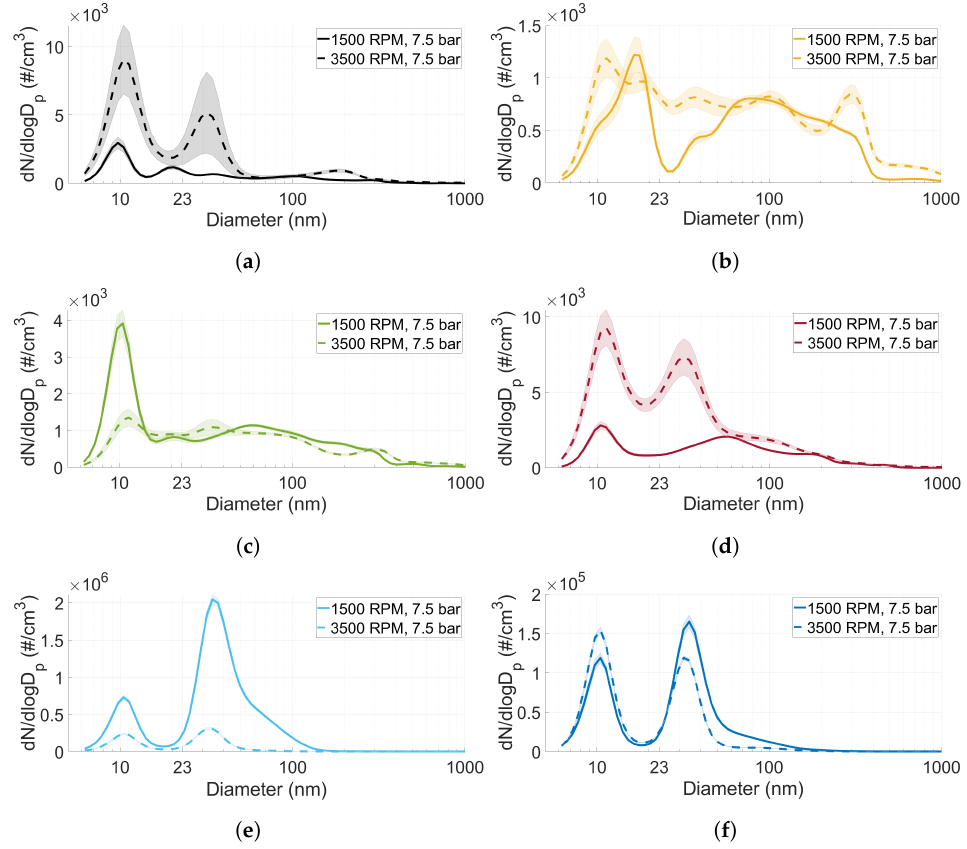
Figure 6. The total particle size distribution for ( a ) gasoline, ( b ) MTBE, ( c ) ethanol, ( d ) methanol, ( e ) n-butanol and ( f ) iso-butanol at low-load conditions. The shadowed areas show the normalised random error ( ± (cid:101)